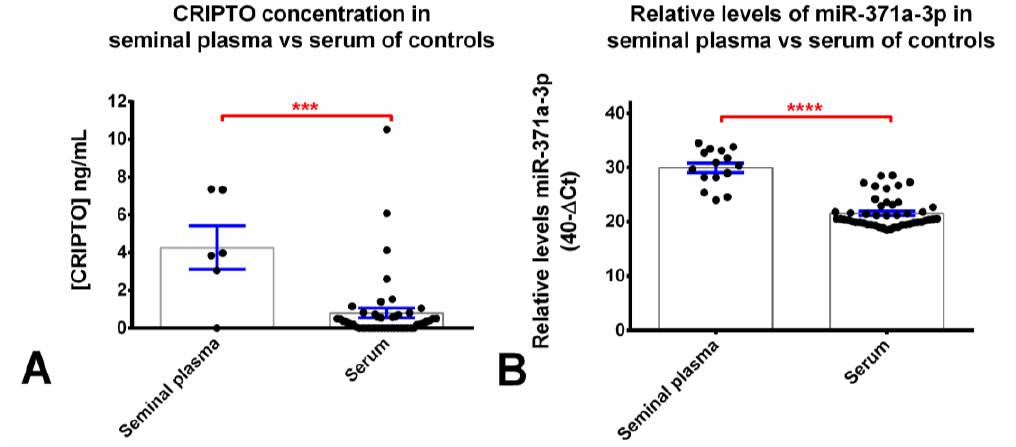
Figure 4. Comparison of CRIPTO concentration ( A ) and miR-371a-3p relative levels ( B ) between serum and seminal plasma male controls. Relative levels of miR-371a-3p were normalized with miR-30b-5p (serum) and miR-20a-5p (seminal plasma) and plotted in the 40- ∆ Ct format. Error bars represent mean ± S.E.M. *** p < 0.001, **** p < 0.0001.